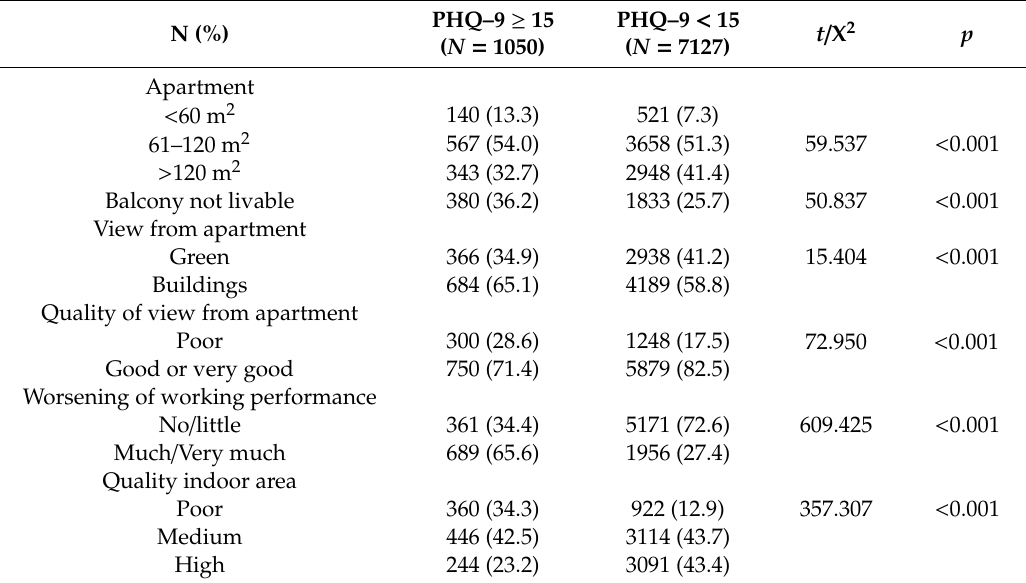
Table 3. Comparison of architectural parameters according to the presence of moderate–severe depressive symptomatology in the student